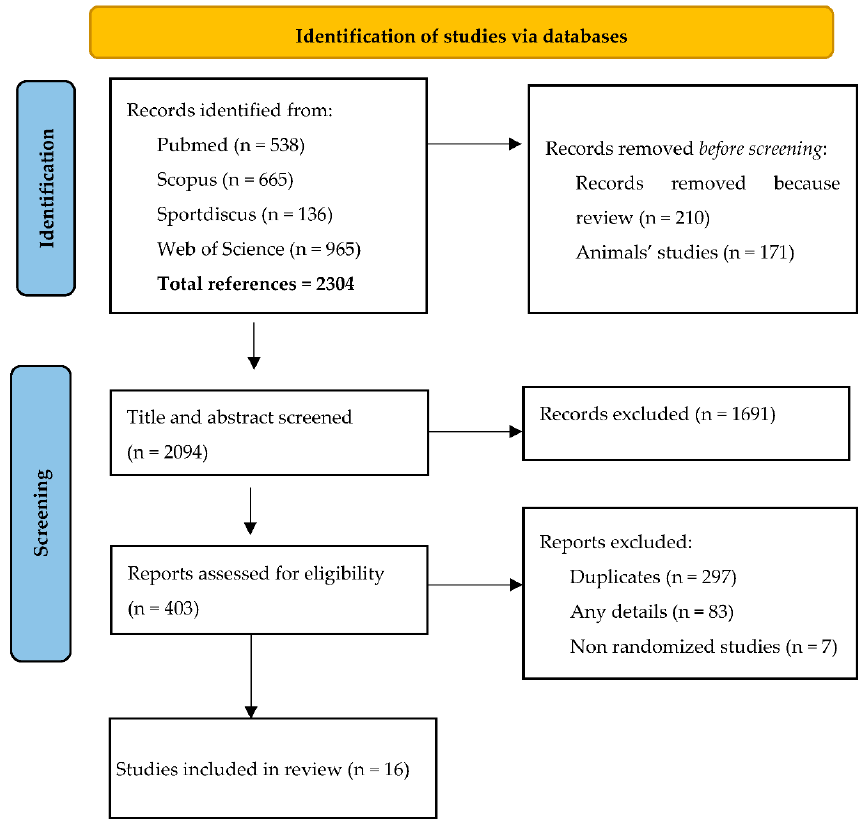
Figure 1. PRISMA flow diagram of the selection of the articles included.